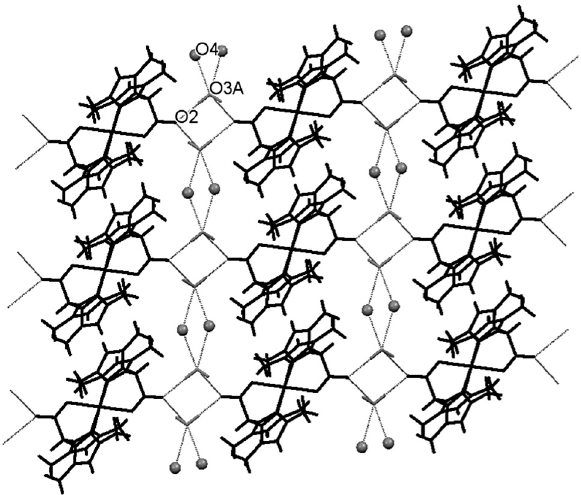
Figure 4. Hydrogen bonding in 4 , considering the presence of O3a (site occupancy ∼ 80%). Extended supramolecular sheets are for- med due to hydrogen bonding between the parallel infinite chains via symmetry disordered O4 water.